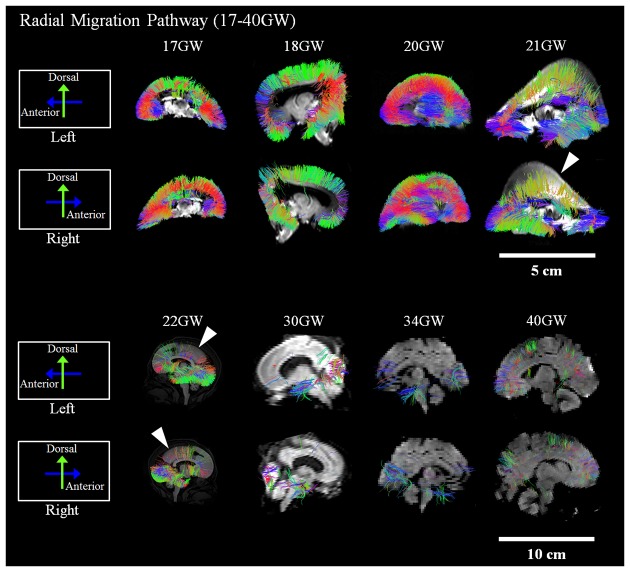
Radial pathways. Tractography at representative ages of the radial pathways are shown in sagittal views. White arrowheads show brain regions where the radial pathways became progressively sparse. Scale bar = 5 cm for 17–21 GW, and 10 cm for 22–40 GW.